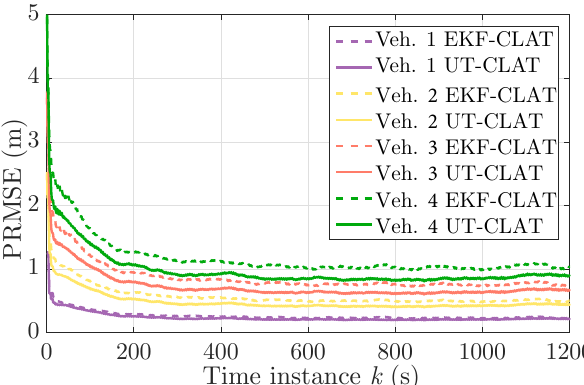
Figure 8. Target distributed estimation PRMSEs of the UT-CLAT vs. the EKF-CLAT for robots 1–4.